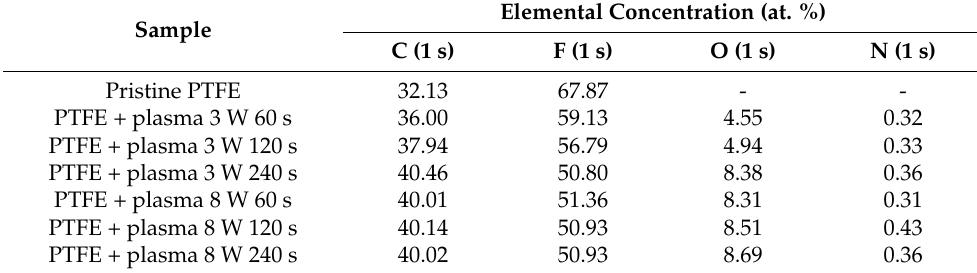
Table 2. Surface atomic concentrations of C, F, O, N elements determined by XPS analysis in pristine PTFE and PTFE treated by plasma at 3 and 8 W for 60, 120, and 240 s. The error of measurement did not exceed 2%.